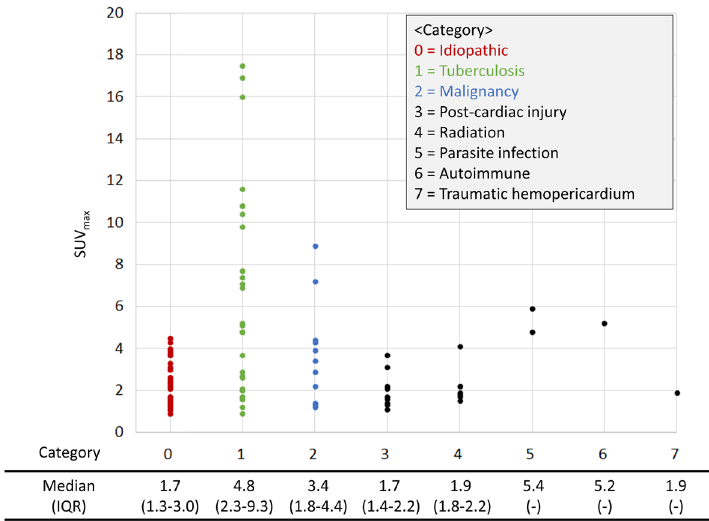
Figure 2. A scatter plot of the pericardial SUV max scores according to the final diagnosis. [Central